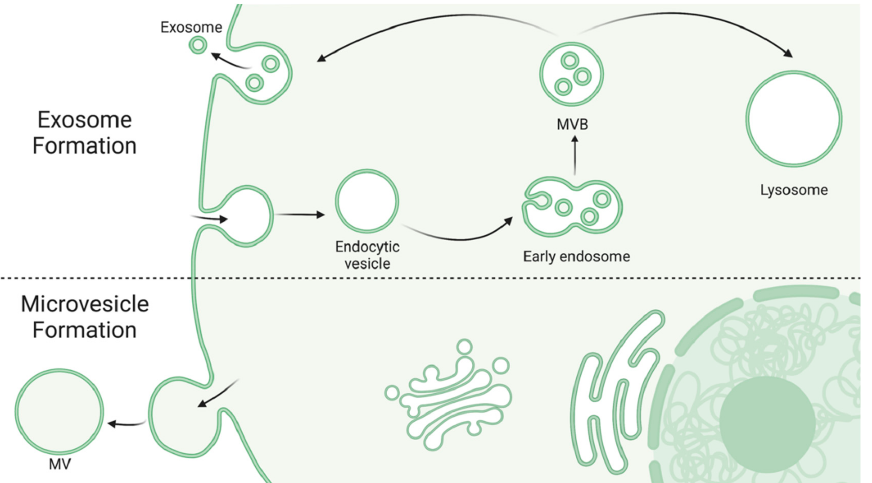
Figure 1. Exosome and MV formation. Exosomes are formed via the inward budding of early endo- somes as they mature into MVBs [35]. MVBs are then either targeted to the lysosome for degradation, where as a result the exosomes are also degraded, or they fuse with the plasma membrane to release their contents [35]. MVs are larger in diameter and formed via the outward budding of the cell’s own membrane [32–34]. Created with